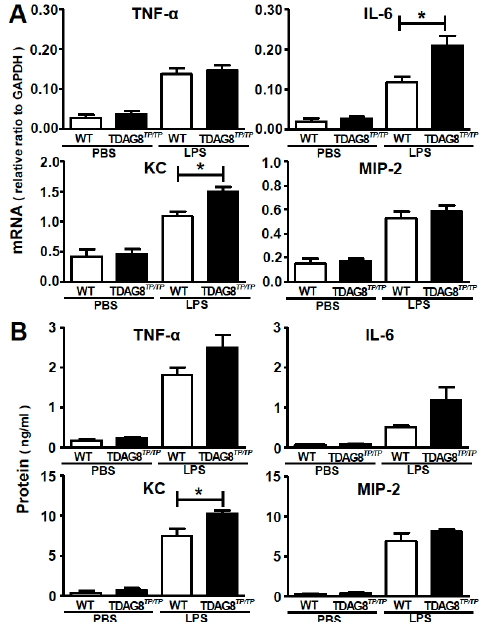
Figure 5. TDAG8 is involved in the regulation of LPS-induced cytokine and chemokine expression. Mice (WT and TDAG8 TP/TP ) were treated with PBS or LPS as described in Figure 3. Cytokine (TNF- α , IL-6) and chemokine (KC/CXCL1, MIP-2/CXCL2) expression levels were evaluated 2 h after intratracheal instillation. ( A ) The mRNA expression of the lungs. Results are expressed as relative ratio to GAPDH; ( B ) The cytokine and chemokine protein level of the BAL fluids. Results are expressed as ng proteins/mL. Data are mean ± SEM of n = 4–10 for each group. The effect of TDAG8 deficiency is significant, * p < 0.05 ( TDAG8 TP/TP -LPS vs. WT-LPS).